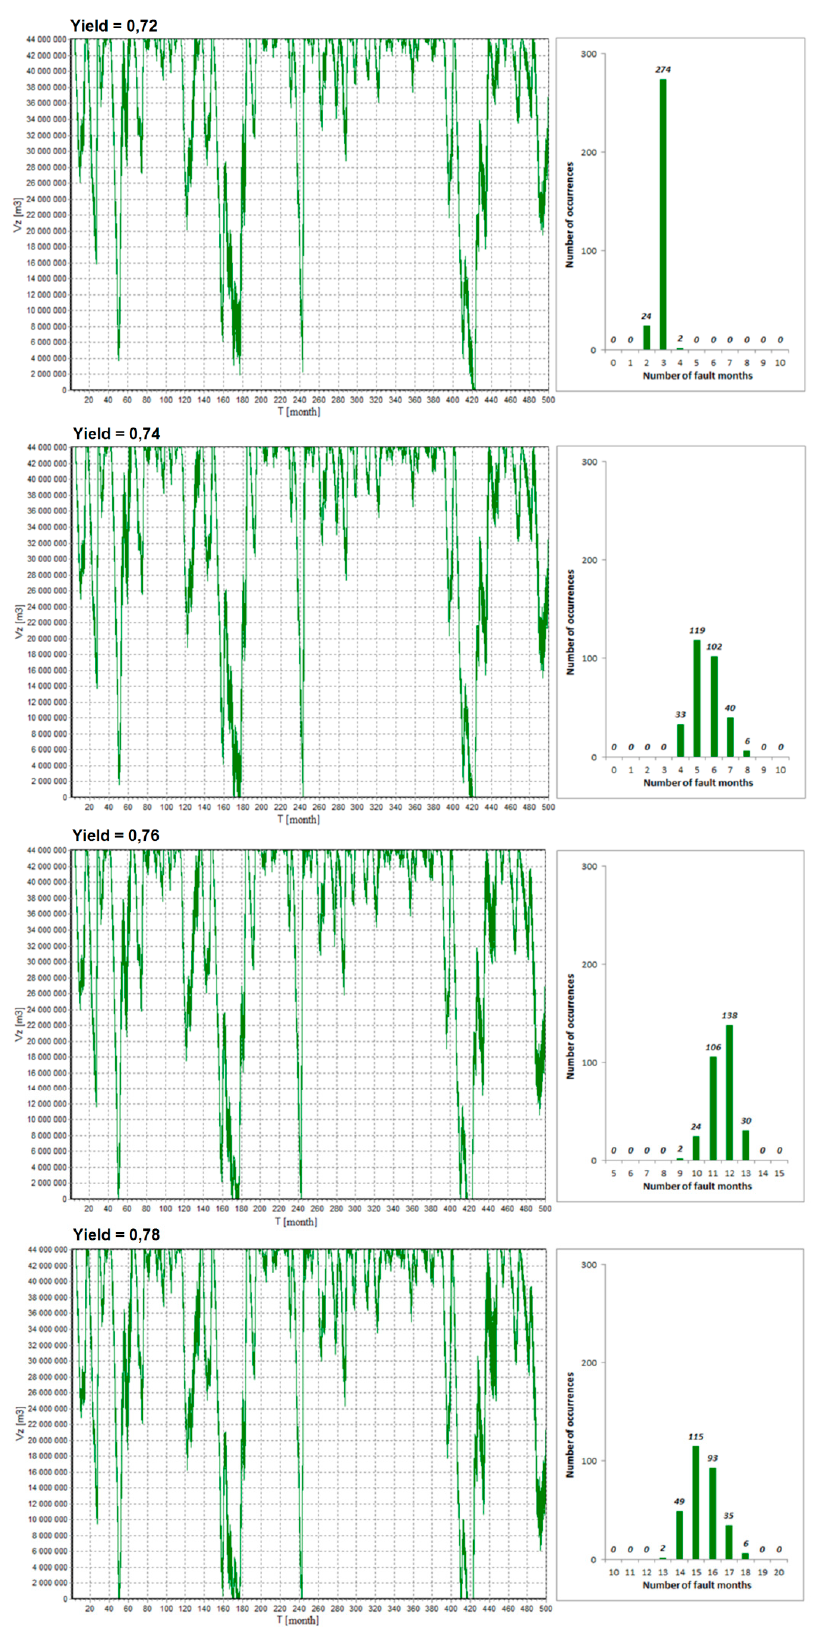
Figure 5. Ensemble of reservoir filling considering water losses from the reservoir for the initial uncertainties of ±9% for 300 random numbers and for the reservoir yield 0.72, 0.74, 0.76 a 0.78 and histograms on the right side show the distribution of numbers of failure months.